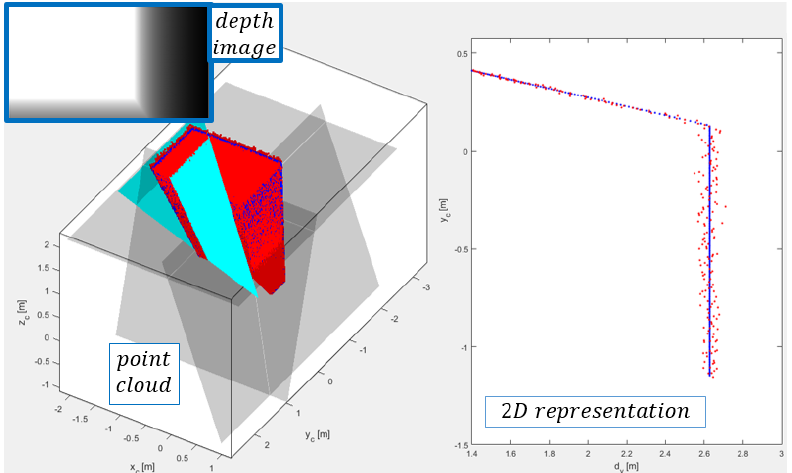
Figure 9. Simulated depth image and the corresponding point cloud on the left side. On the right side is demonstrated an example of the 2D representation of spatial points, on a plane section, which is represented as a set of planar rays. Ideal data are colored blue and corrupted data